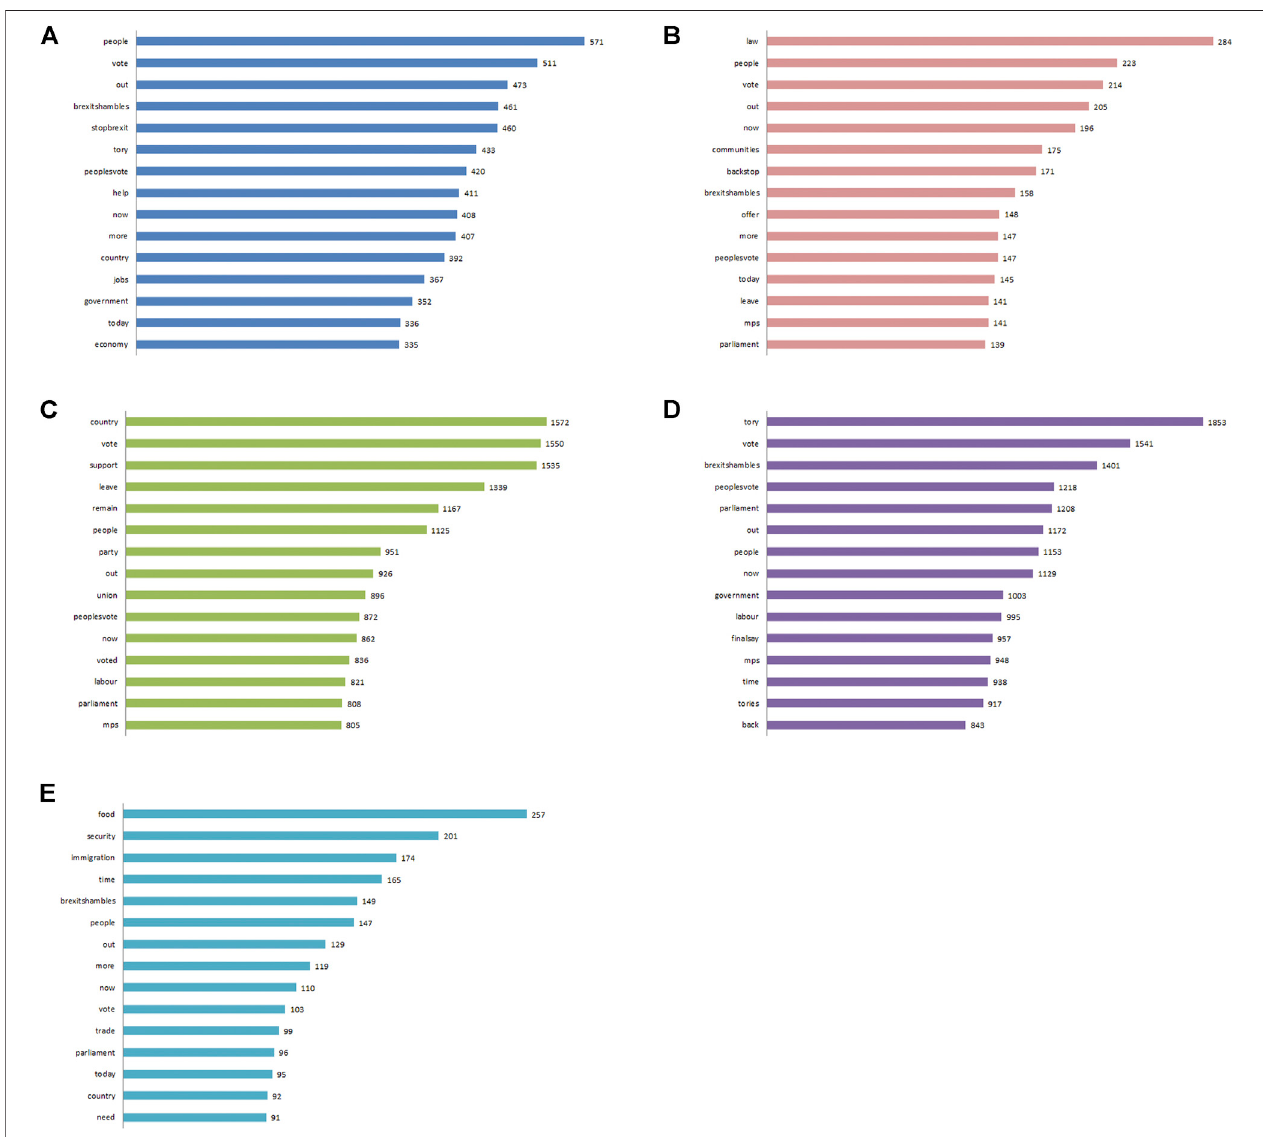
FIGURE4| Wordcloudsandfrequenciesperfoundation-Care (A) ,Fairness (B) ,Loyalty (C) ,Authority (D) andSanctity (E) .Wordsaresizedbytheirfrequencyand colored randomly. Frequency bars for words containing 3 characters or more are shown on the right.